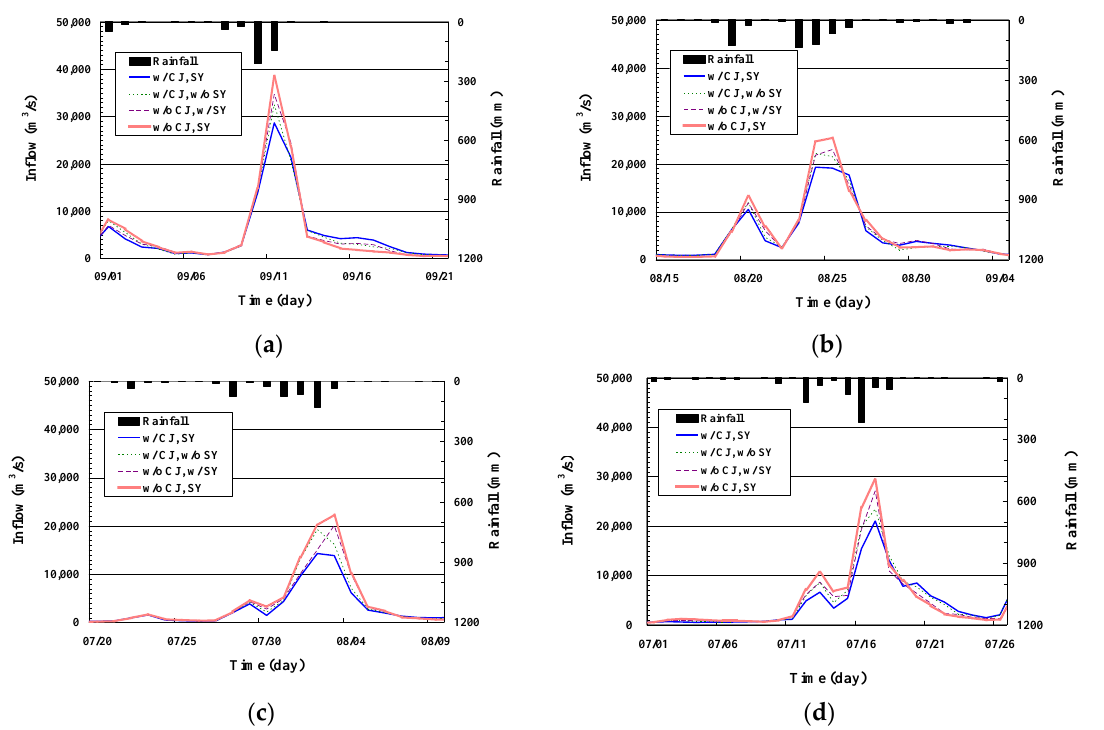
Figure 8. Hydrographs according to the Scenarios at the Paldang Dam. ( a ) 1990; ( b ) 1995; ( c ) 1999; ( d ) 2006.